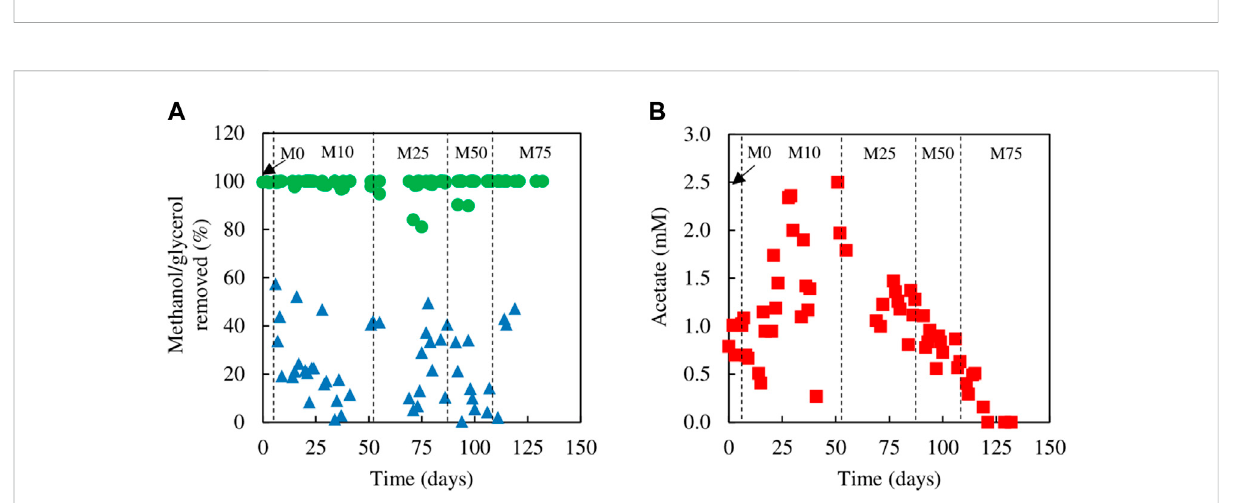
FIGURE 2 (A) Changes in HRTs ( C ) with varying relative percentages of methanol ( ■ ) used in the feed liquor of the sul fi dogenic bioreactor, and (B) variations in rates of sulfate reduction (blue bars) and hydrogen sul fi de generation (green bars) in each combination of methanol and glycerol tested ( n = 11).